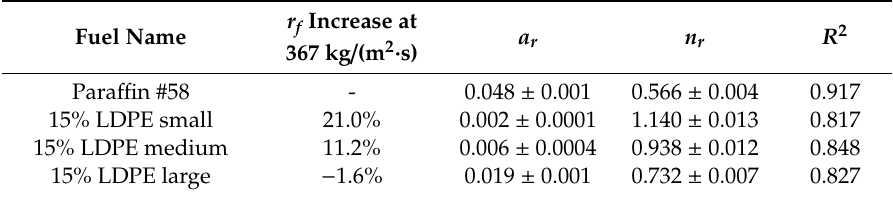
Table 6. r f increase and fitting results of r f vs. G ox for low-density polyethylene (LDPE) particles / para ffi n composite fuels, 15% LDPE showing decreasing slope n r for increasing particle size [28]. Copyright Begell House (2017). Reproduced with permission.